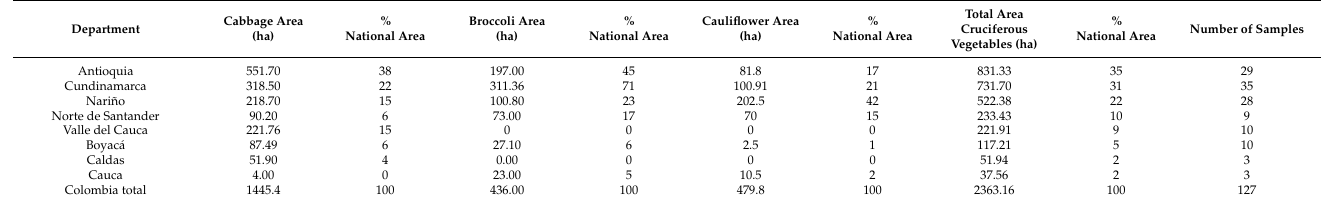
Table 1. Area sown to cruciferous vegetable crops in Colombia in 2016 [46] and number of samples collected from each department in this